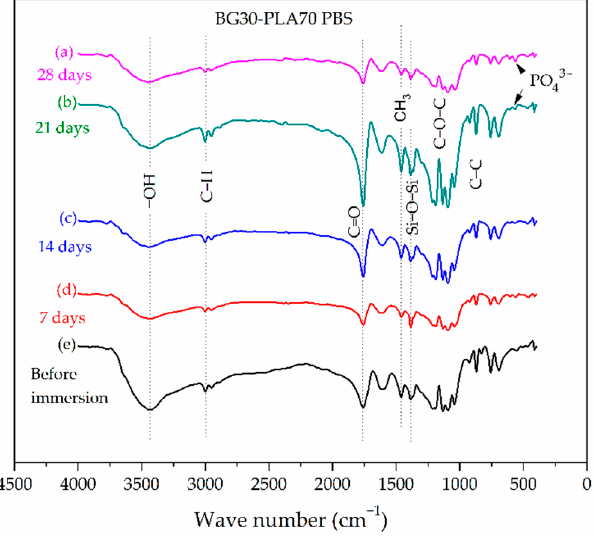
Figure 6. FTIR spectra of the BG30-PLA70 composite after different soaking times in PBS.